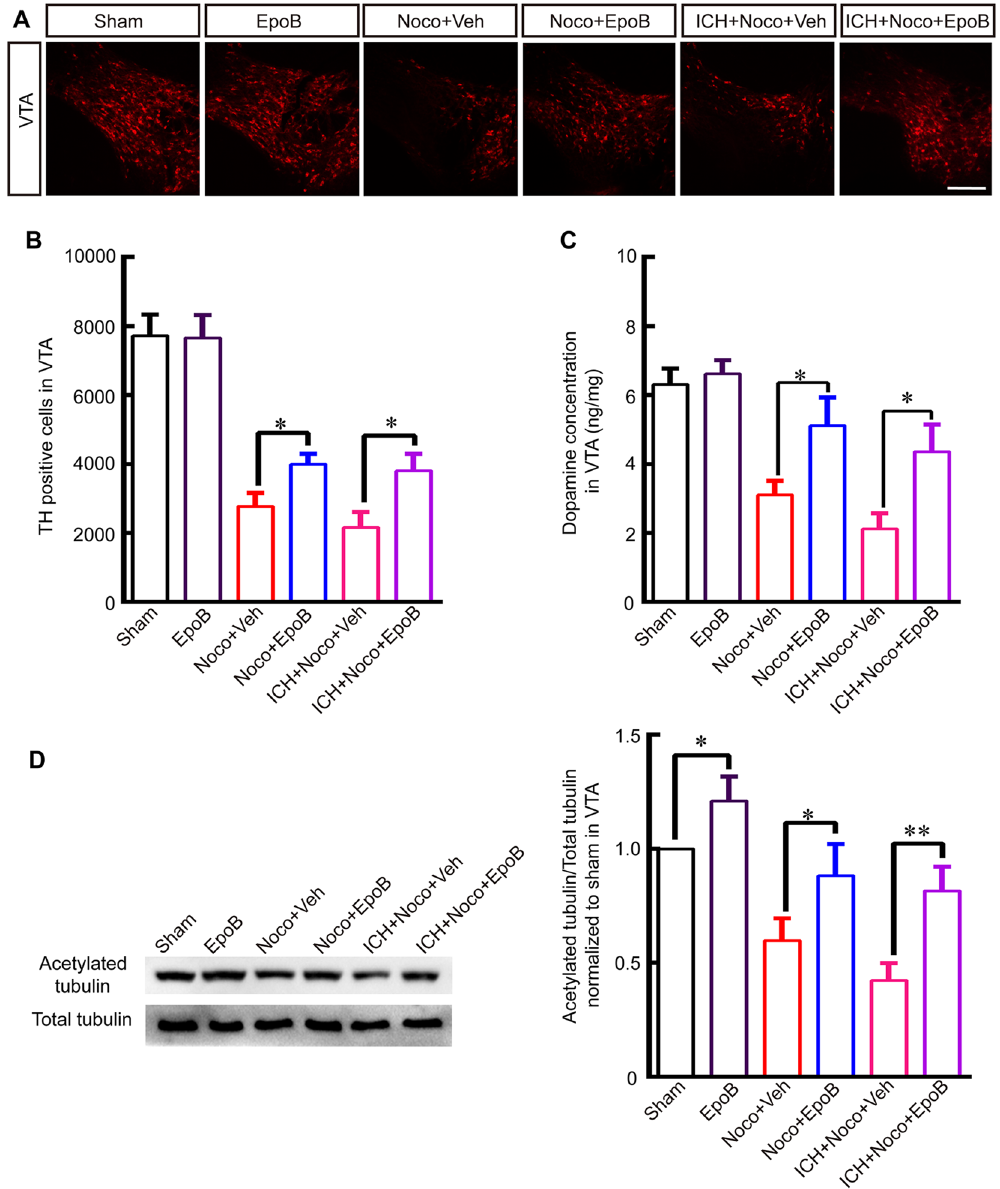
Figure 4. Noco-induced MT depolymerization aggravated ICH injury and EpoB treatment protected VTA DA neurons’ injury against Noco-induced MT depolymerization. ( A ) Representative immunofluorescence staining for TH in VTA in the Sham, EpoB, Noco + Veh, Noco + EpoB, ICH + Noco + Veh and ICH + Noco + EpoB groups at 14 days after Noco injection or ICH (Scale bar = 100 μ m). ( B - C ) Quantitative data for TH-positive cell ( B ) and DA concentrations ( C ) in the VTA in the Sham, EpoB, Noco + Veh, Noco + EpoB, ICH + Noco + Veh and ICH + Noco + EpoB groups at 14 days after Noco injection or ICH. ( D ) Representative Western blot images and quantitative data for acetylated α -tubulin and total tubulin expression in the VTA in the six groups at 14 days after Noco injection or ICH (Full-length blots/gels are presented in Supplementary Figure S3). Data are shown as the means ± SEM (at least n = 5 for each group; * P <